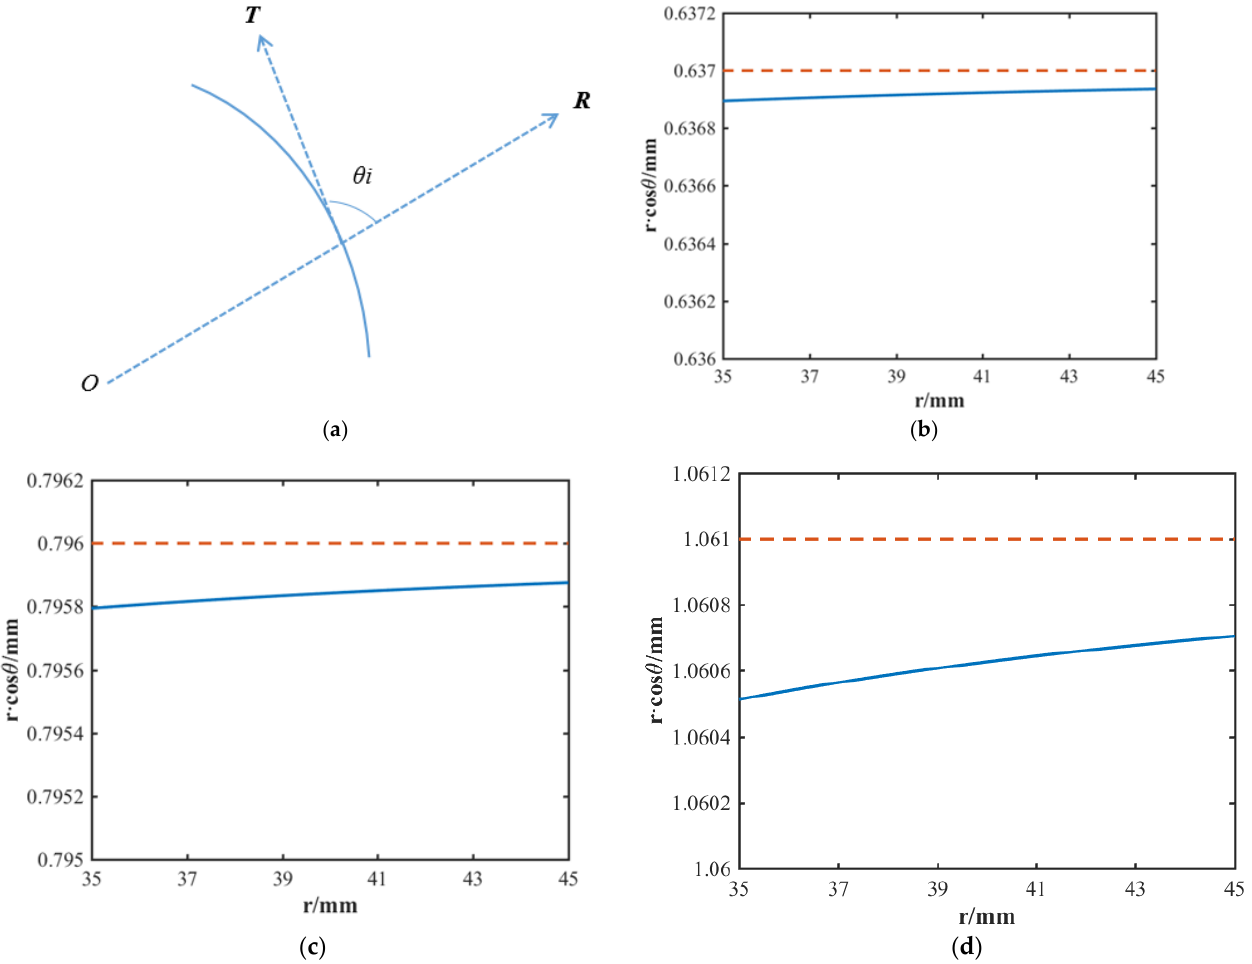
Figure A5. ( a ) The angle between the radial direction ( R ) and the direction of velocity ( T ) at any position in the spiral microchannel; ( b – d ) the relationship between r and r · cos θ for the change rate of the spiral radius of 0.637 ( b ), 0.796 ( c ), and 1.061 ( d ) mm/rad.